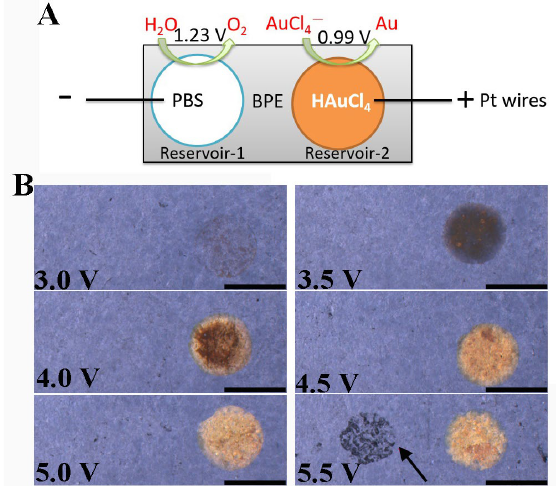
Figure 1. Bipolar electrodeposition of Au particles on one pole of the GP BPE. ( A ) Schematic representation of bipolar deposition of Au on one pole of GP BPE. ( B ) Optical images of Au film obtained under various external voltages from 3.0 to 5.5 V for 300 s. The concentration of HAuCl 4 was 5 mM. The red arrow indicates the corrosion of GP in the right reservoir; the scale bar represents 3 mm.